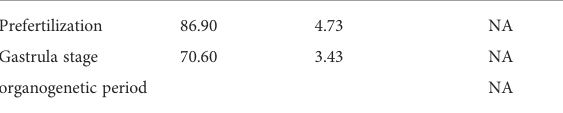
TABLE 8 Isotopic abundance in the different tissues of S. schlegelii at different development stages (unit: 15 N atom%). Serum Peripheral tissue